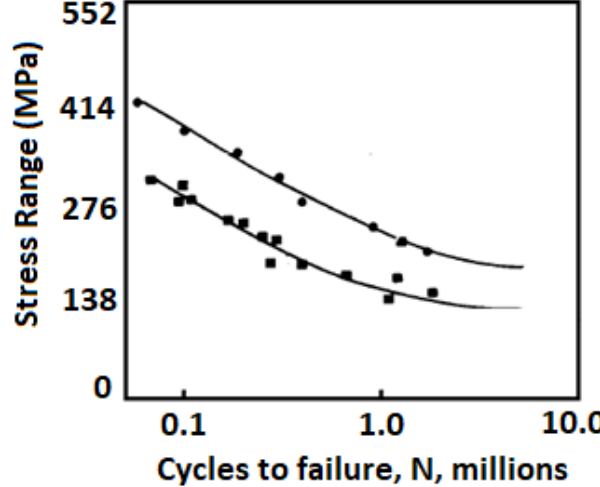
Figure 1. S-N curves for reinforcing bars (adapted from ACI 215R-74